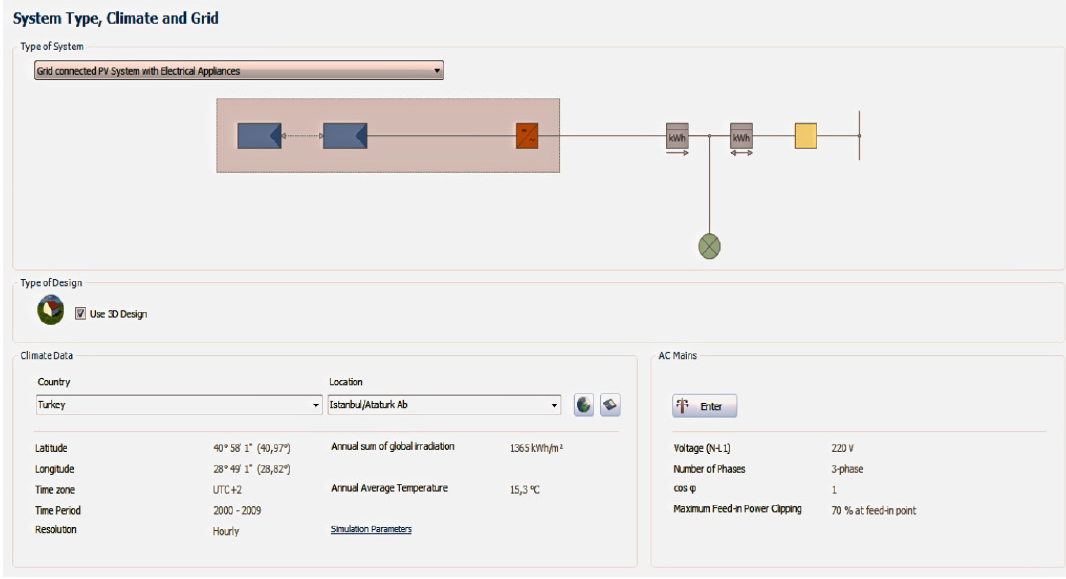
Figure 7. Main system type and inputs.